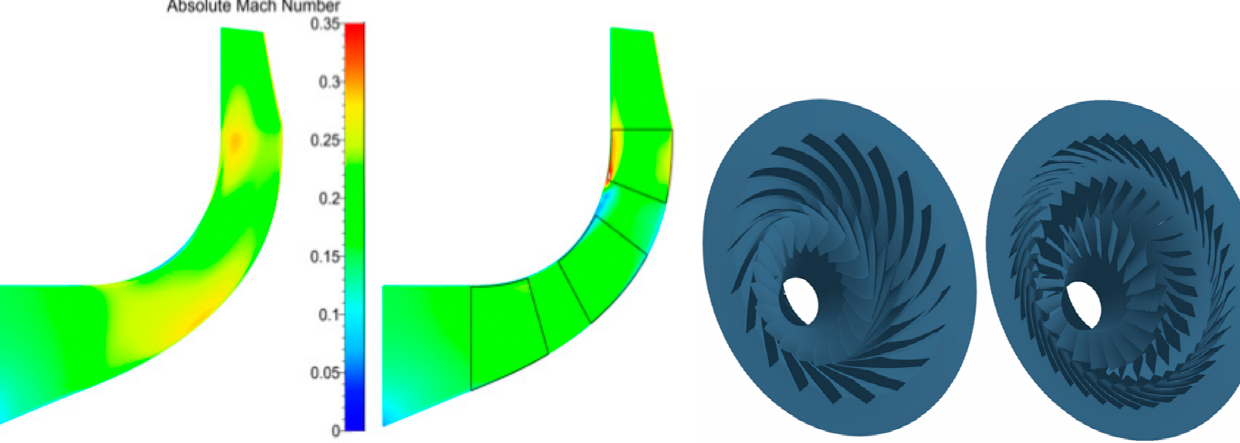
Figure 24. Axisymmetric view of absolute Mach contours and 3D views compared between both configurations.